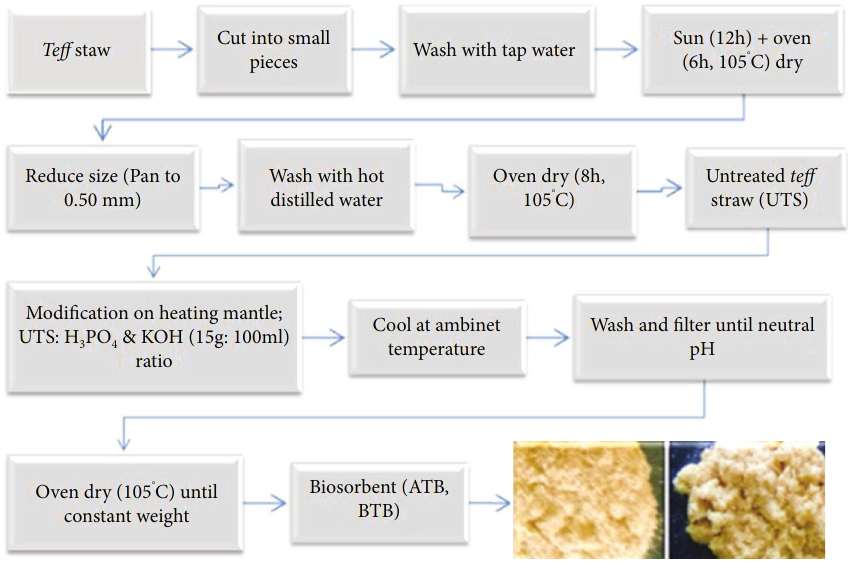
Figure 1: Schematic representation of Te ff straw biosorbent